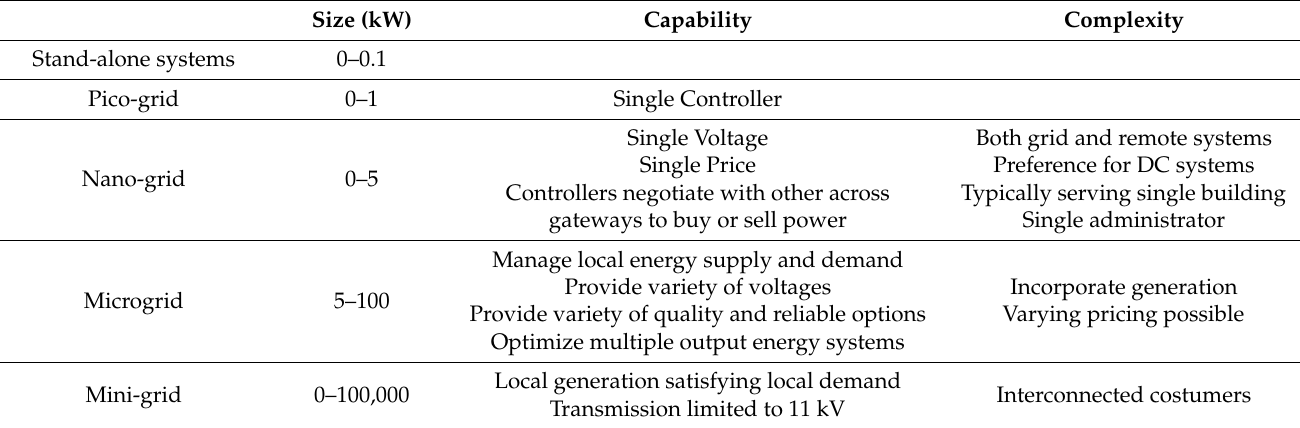
Table 2. Network separation based on system size, capabilities and complexity